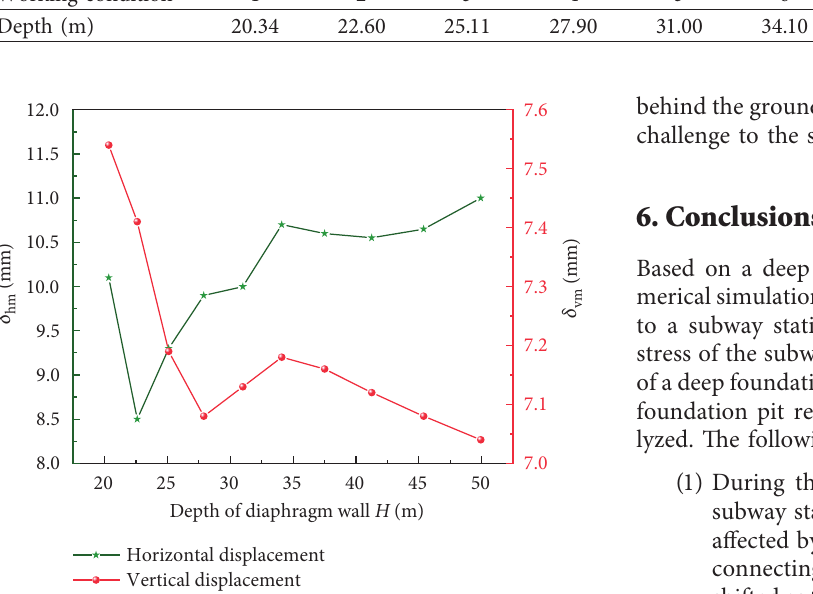
Table 4: Simulation conditions of foundation pit excavation with different depths of the diaphragm wall. Working condition